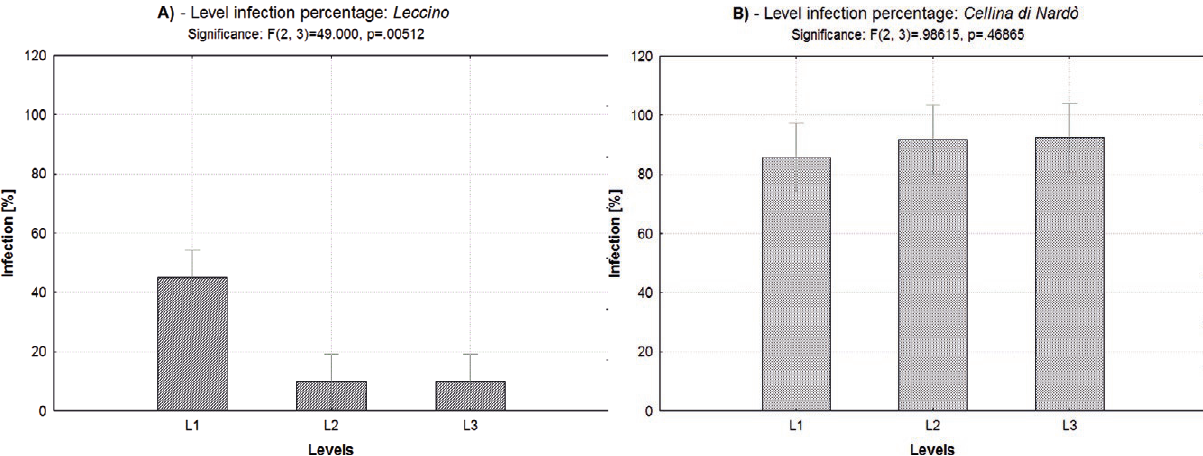
Figure 2. Mean infection rates in ‘Leccino’ (A) and ‘Cellina di Nardò’ (B) olive cultivars, as indicated from testing 240 twig samples per cul- tivar at the three canopy levels: low (L 1 ), medium (L 2 ), high (L 3